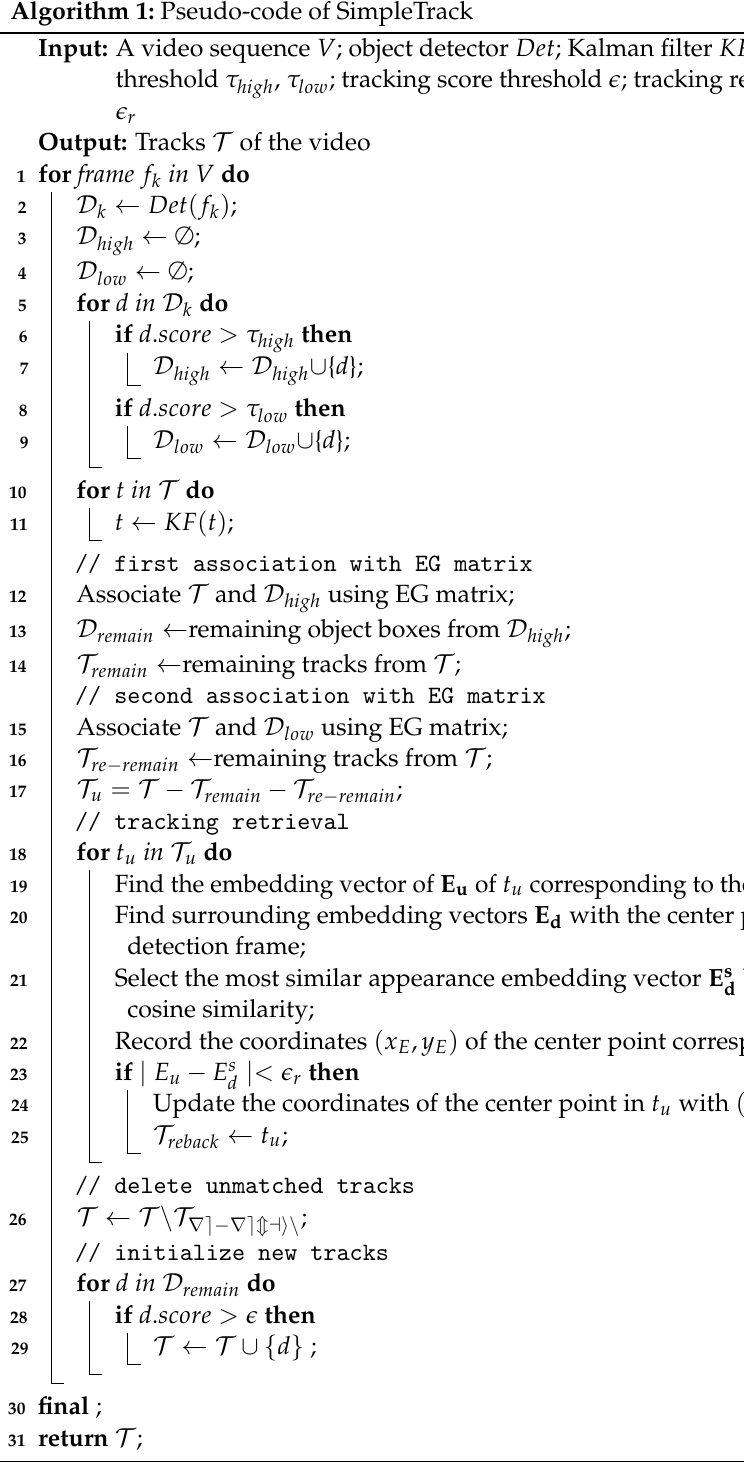
Algorithm 1: Pseudo-code of